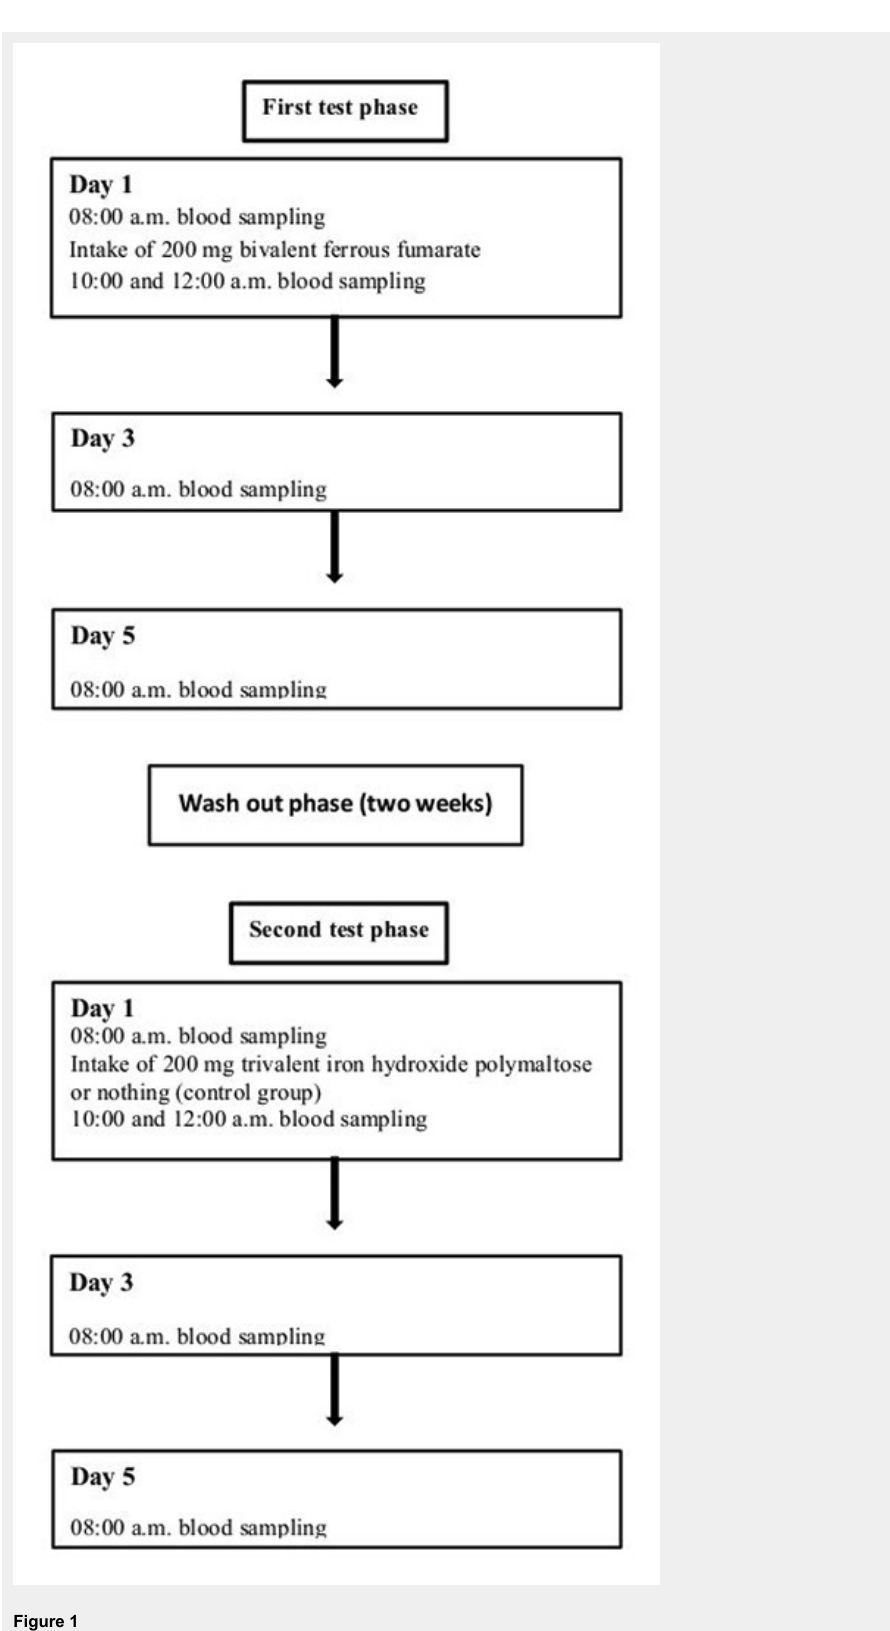
Figure 1 Illustration of the study